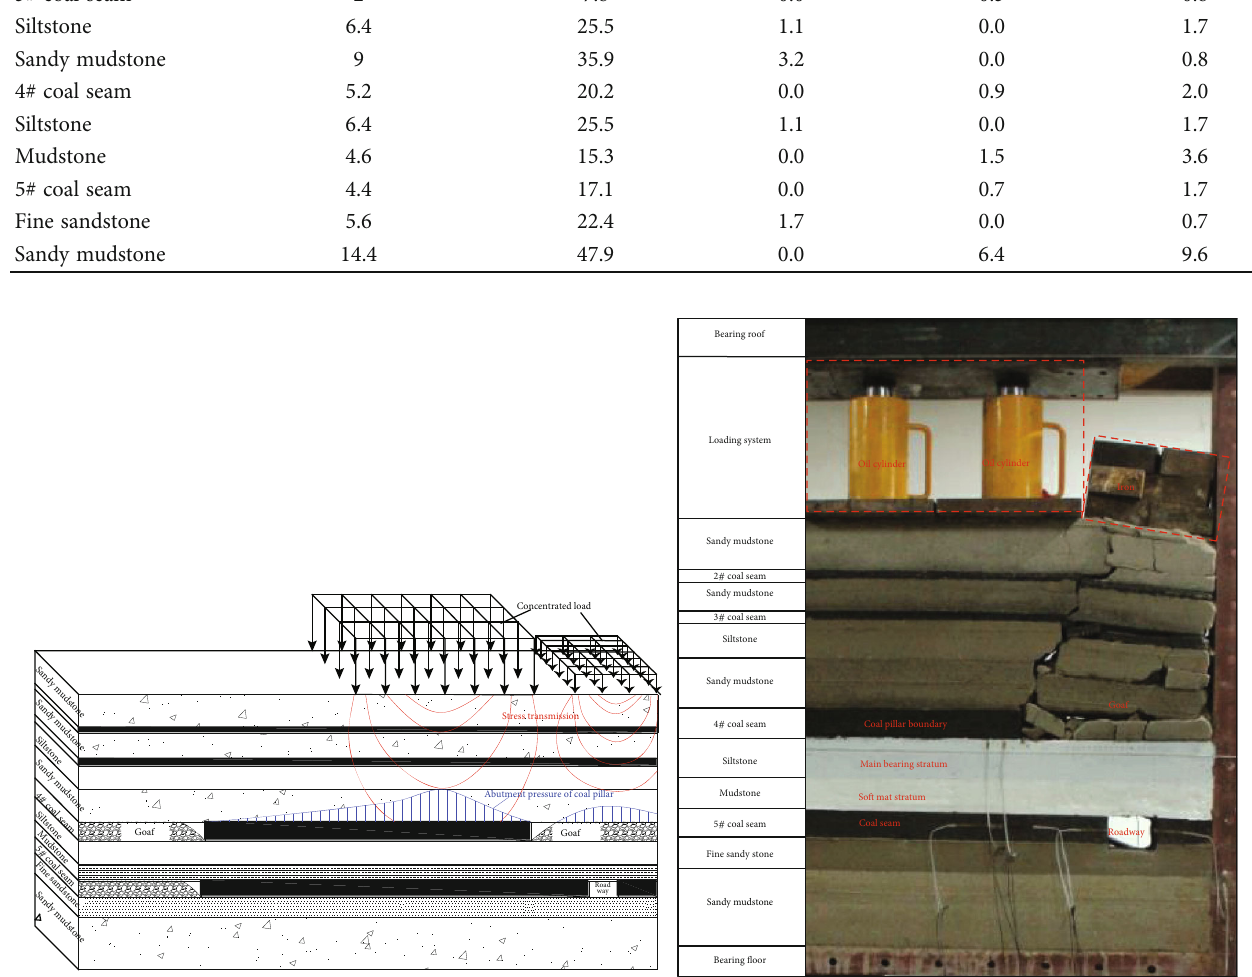
Figure 14: Similarity simulation model design.